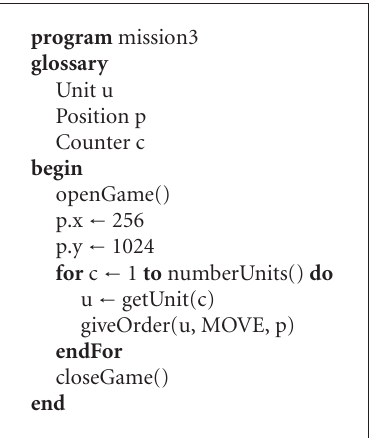
Algorithm 2: Mission three algorithm.